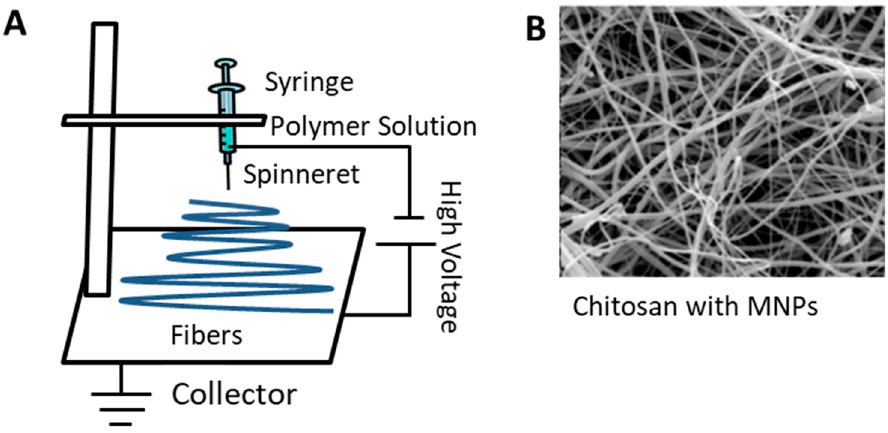
Figure 3. ( A ) Common vertical set-up for electrospinning, along with ( B ) an example of chitosan nanofibers with MNPs (Scale in B: 100 nm). (B is reproduced from open access Ref [122] , De Gruyter, 2017).